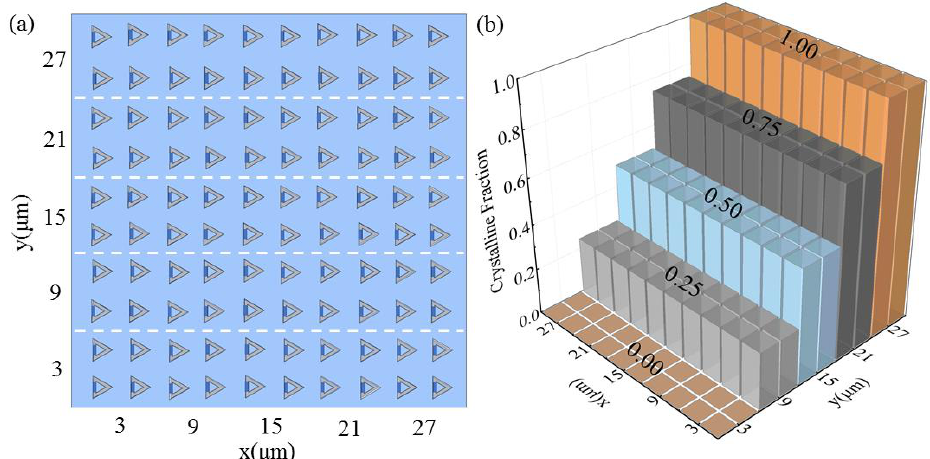
Figure 7. ( a ) Scheme of metasurface for thermal imaging; ( b ) crystalline fraction distribution on the metasurface.